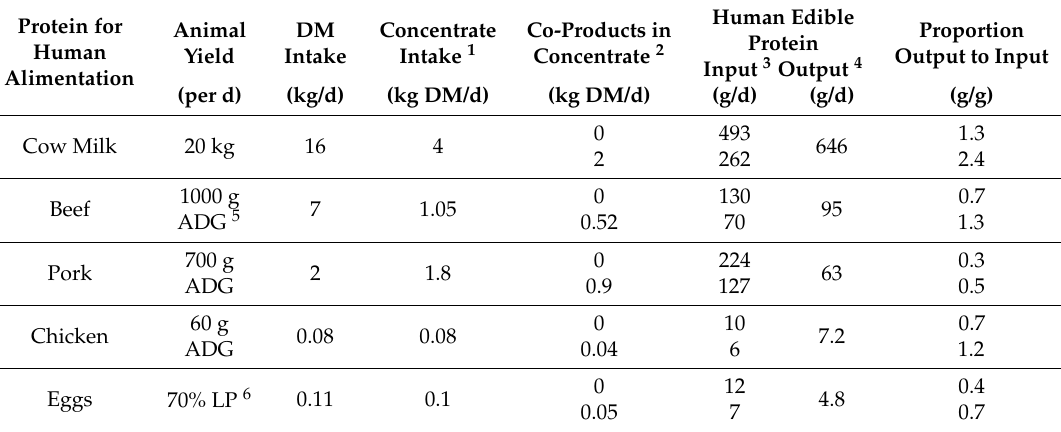
Table 11. Calculation of the net protein contribution of food of animal origin to the human food chain without co-products and under consideration of 50% of concentrate based on co-products (based on data of Tables 2 and